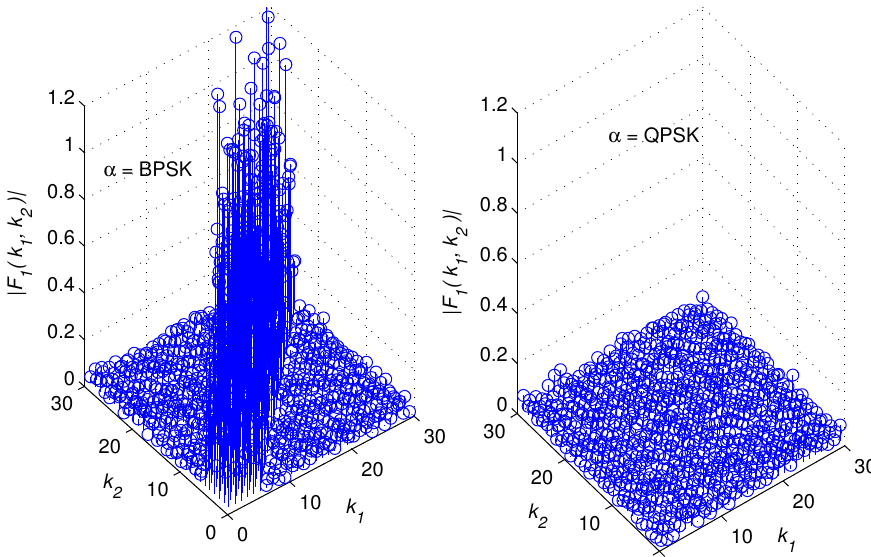
Figure 2. | F 1 ( k 1 , k 2 ) | for BPSK and QPSK